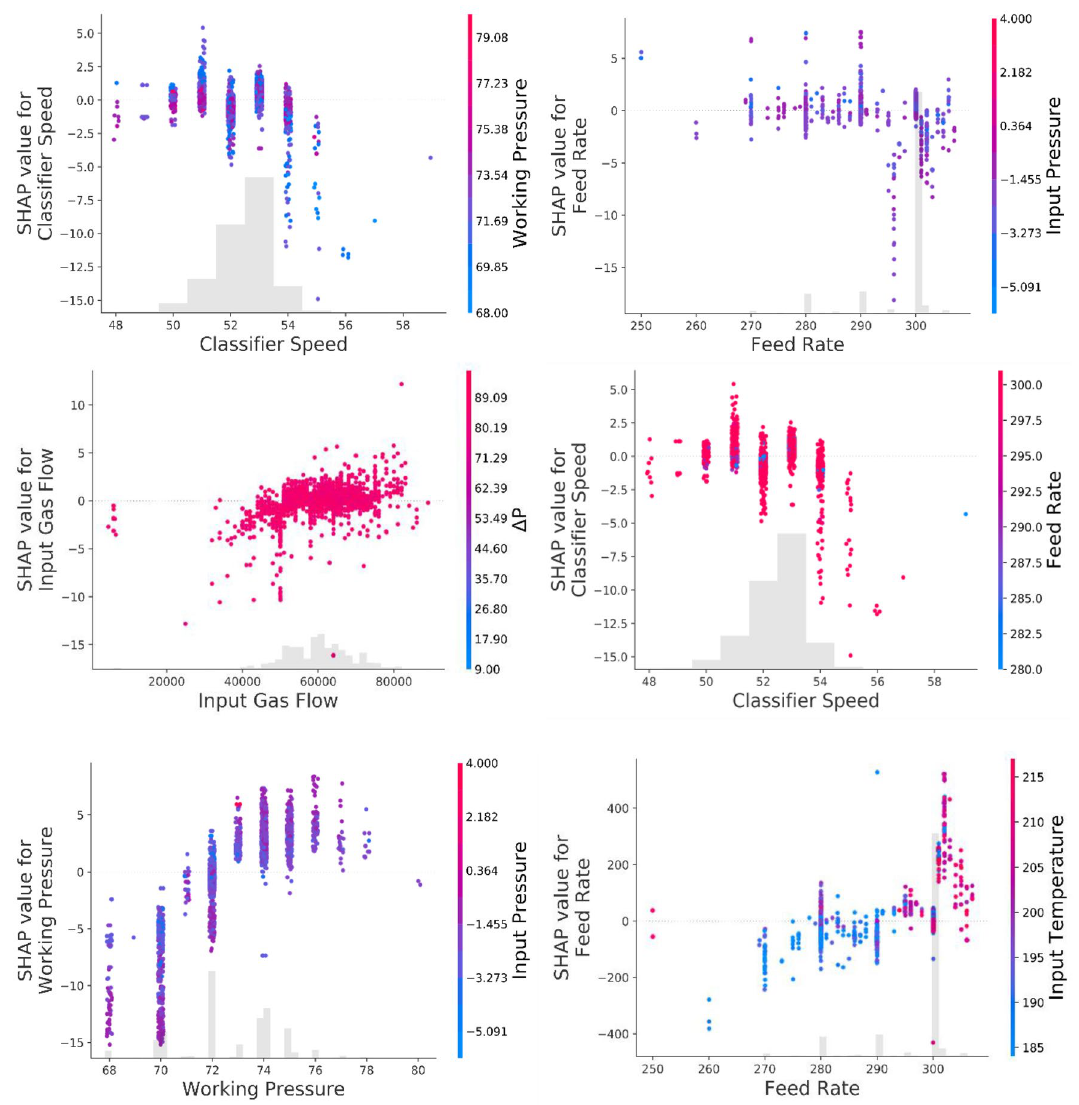
Figure 3. SHAP assessed the complexity of inter-correlations between VRM operational